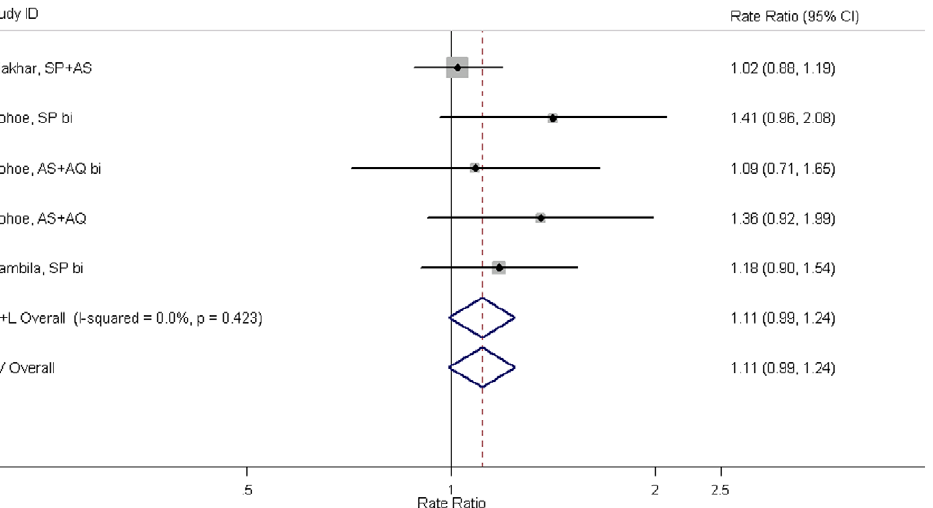
Figure 3. Effect of IPTc on clinical malaria (any level of parasitaemia) during the subsequent transmission season (following IPTc administration). NOTE: D + L Overall=Random effect meta-analysis, I–V Overall=Fixed effect meta-analysis. AQ: amodiaquine, AS: artesunate, bi: bimonthly administration, CI: confidence interval, SP: sulphadoxine pyrimethamine.